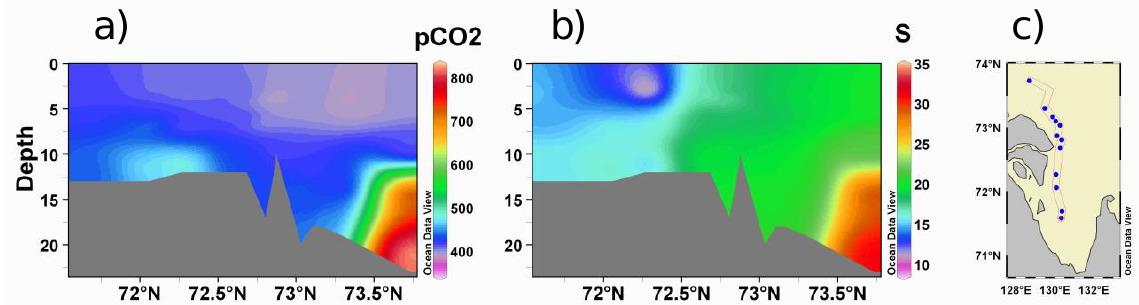
Fig. 11. Distribution of CO 2 partial pressure ( p CO 2 , µatm) (a) and salinity (b) in the water column of the Buor-Khaya Bay along transect observed in 2011. Position of transect is shown in (c) .